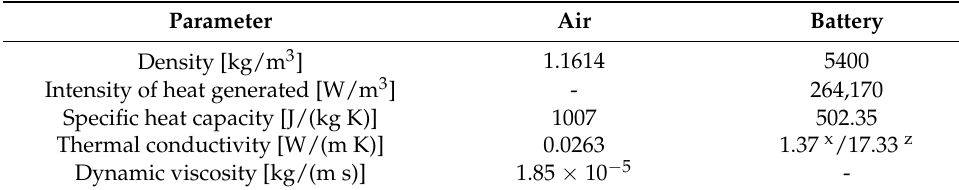
Figure 5. The geometry and grids of battery pack. Table 2. Parameters of battery and air.